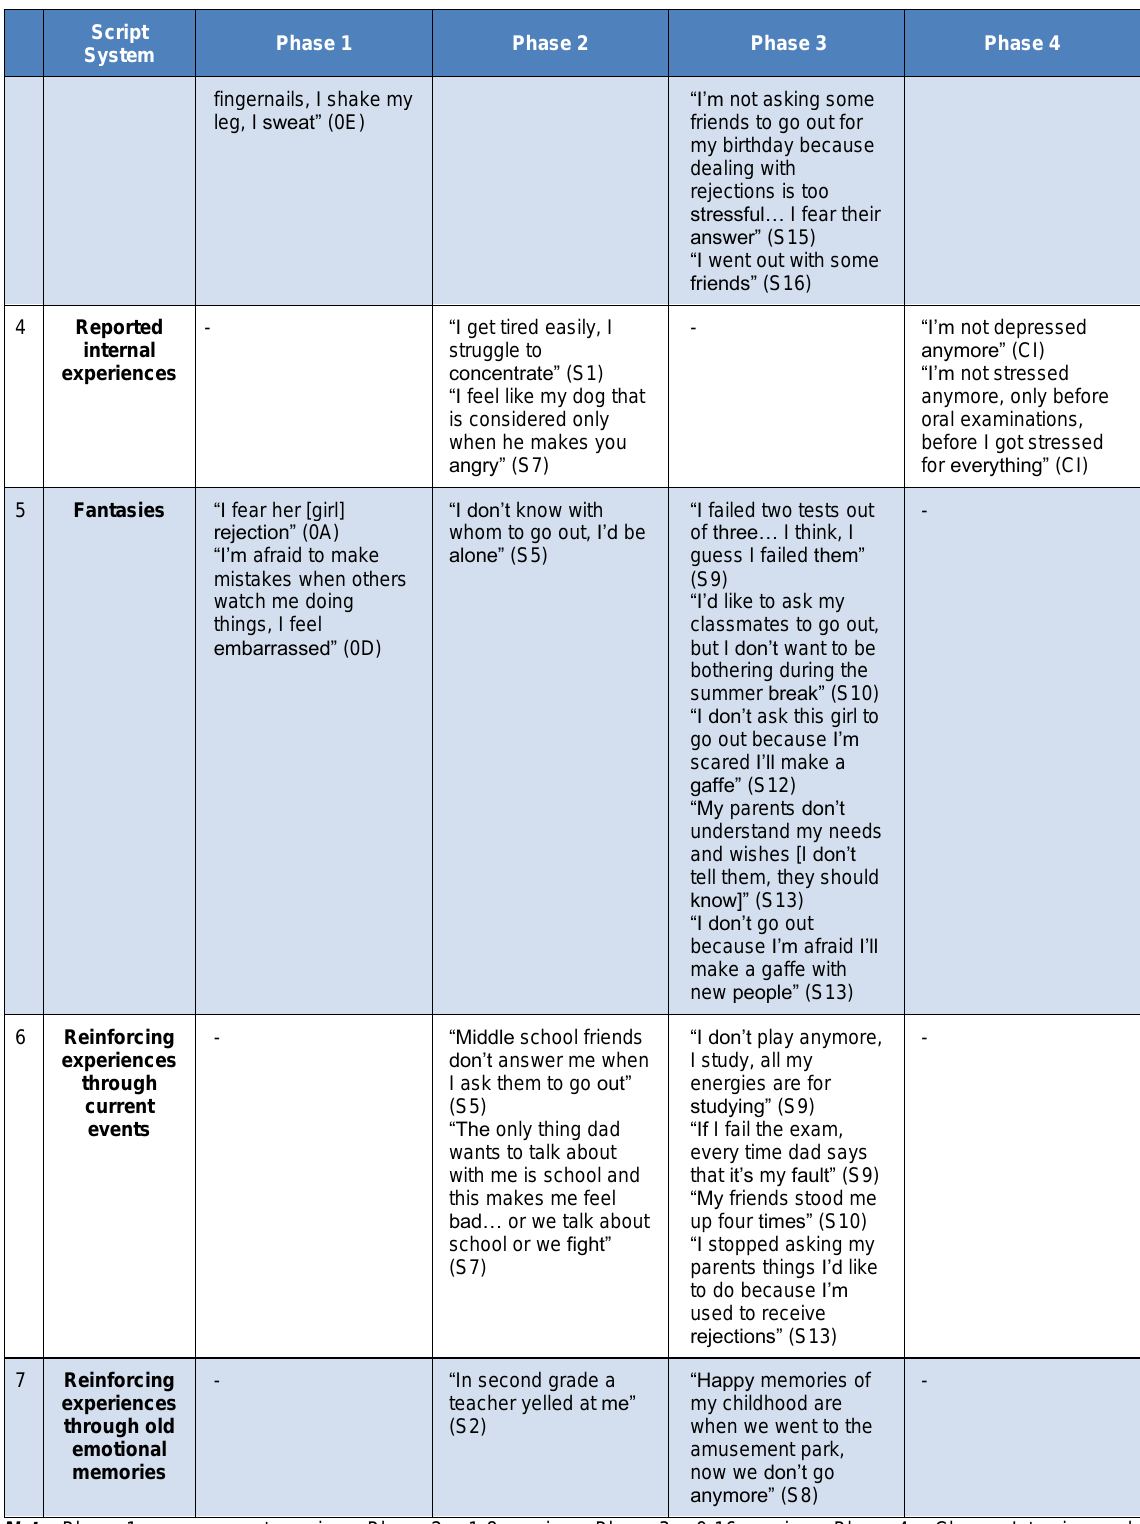
Table 3: How Giovanni’s Script System changed from Phase 1 to Phase